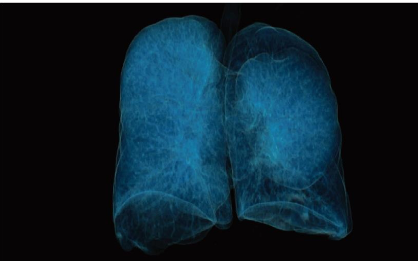
Figure 3: CTchest 3D reconstruction showing decreased lung feld on bilaterally lower lobes and the left upper lobe.